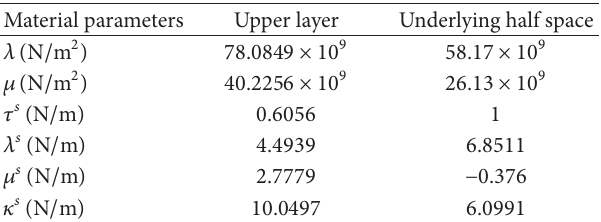
Table 3: Material properties employed in numerical